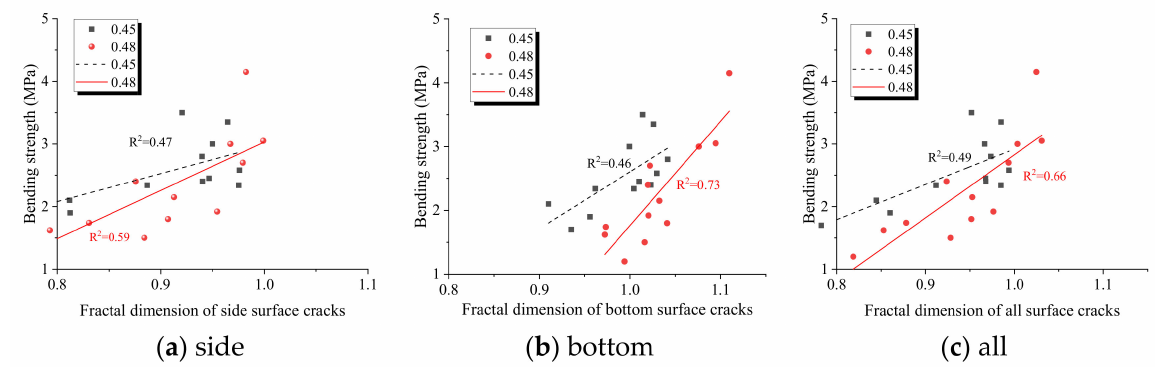
Figure 15. Relationship between bending strength and fractal dimension.